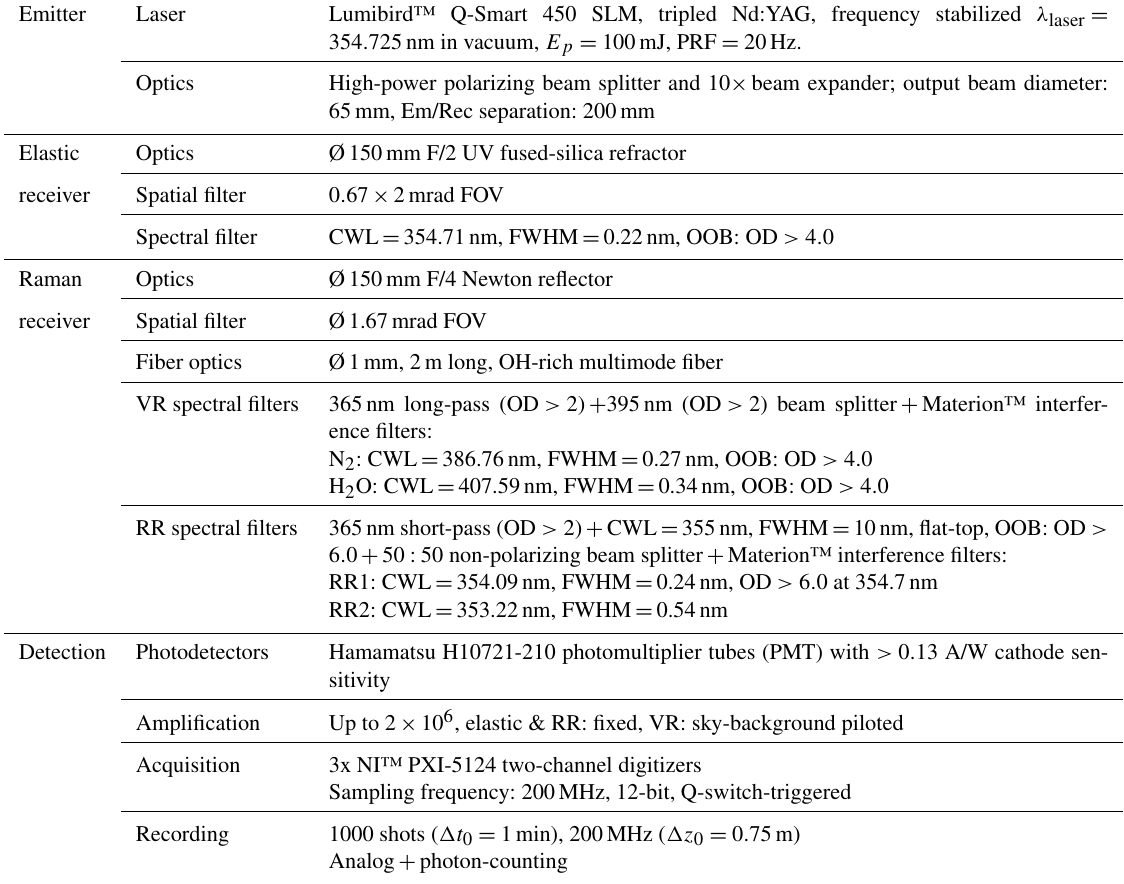
Table 2. WALI instrument characteristics summary (PRF: pulse repetition frequency; FOV: field of view; CWL: central wavelength in vacuum; FWHM: full width at half maximum; OOB: out-of-band blocking specification; OD: optical